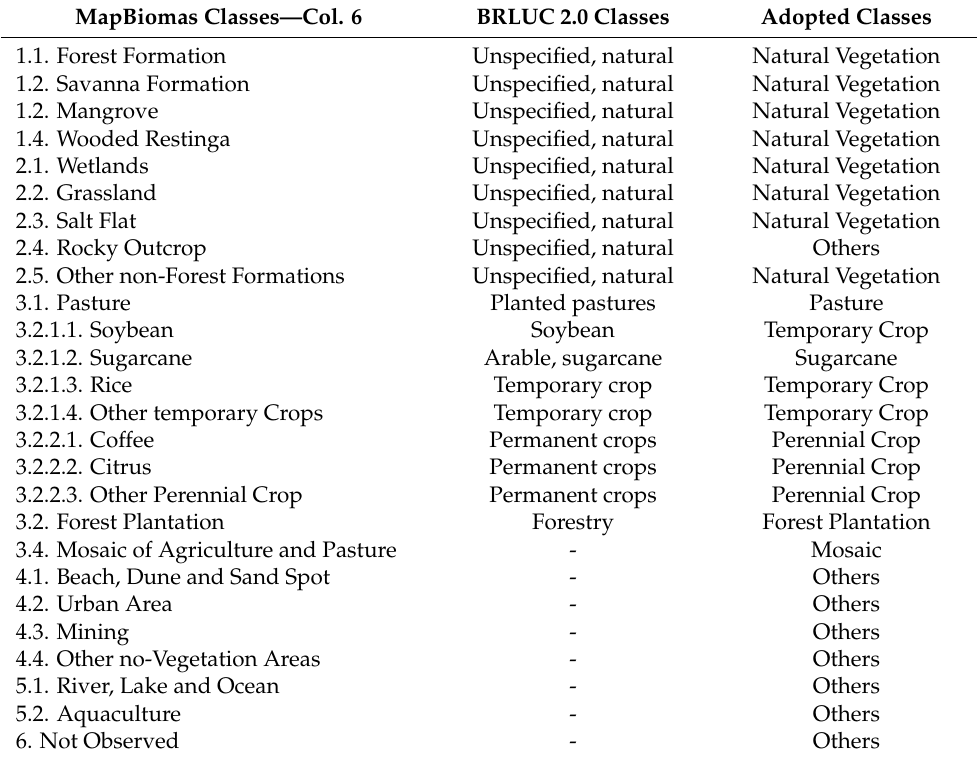
Table 1. MapBiomas class grouping and correspondence with BRLUC 2.0. MapBiomas Classes—Col.